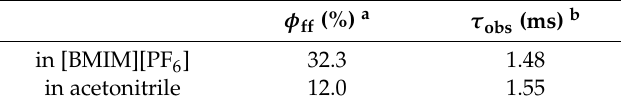
Figure 3. Emission spectra of the helical Eu complex with L ( a ) in [BMIM][PF 6 ] compared with ( b ) in acetonitrile [4] ( λ ex = 328 nm). Table 1. Luminescence quantum yields ( φ ff ) and luminescence lifetimes ( τ obs ) of the helical Eu complex with L in [BMIM][PF 6 ] and in acetonitrile [4] ( a : λ ex = 328 nm, λ mon = 550–782 nm, b : λ ex = 340 nm, λ mon = 616